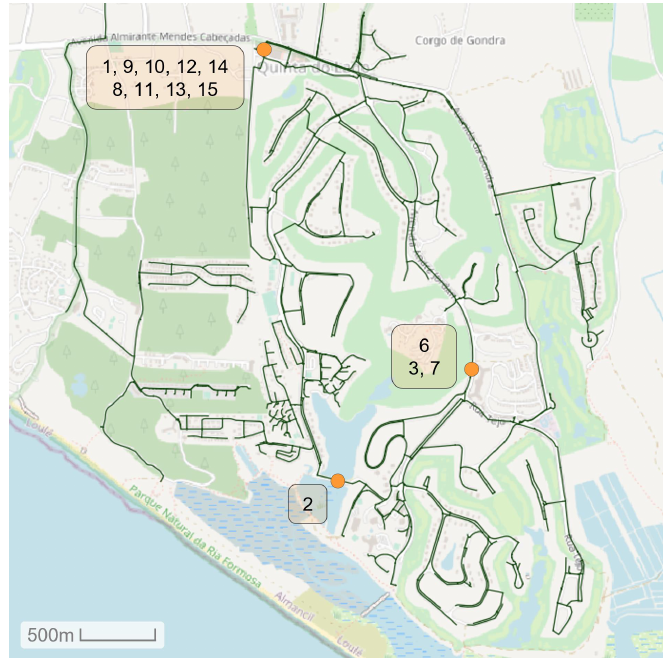
Figure 5. Overview of the real sensors’ location in Infraquinta’s WDN.